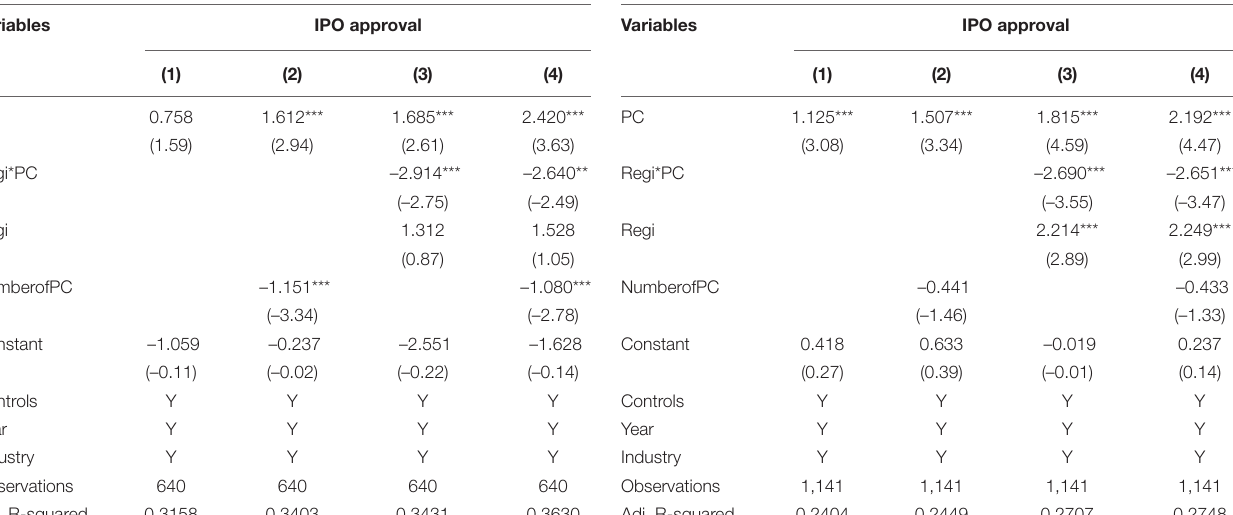
TABLE 9 | Sample of GEM. TABLE 10 | Sample eliminated the effect of strict